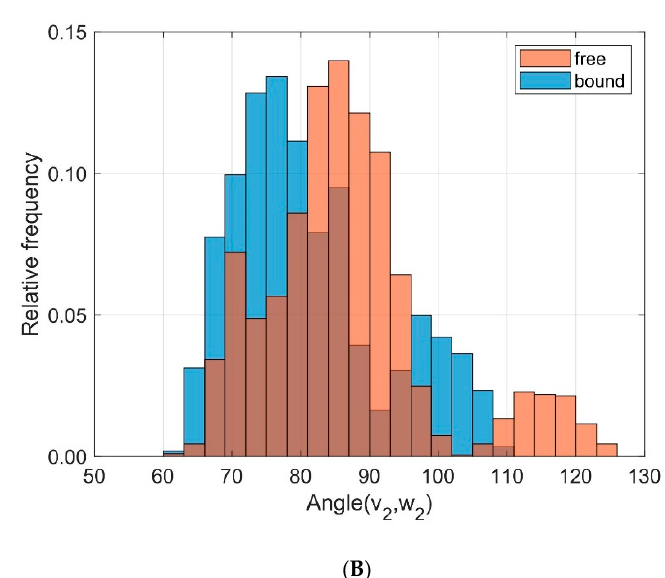
Figure 8. Frequency distribution of angles between corresponding principal component eigenvectors of domains MHC α 1 and MHC α 2 for bound (blue) and unbound states (orange). ( A ): Angles between eigenvectors v 1 , w 1 corresponding to the main extensions ( D = 0.255); ( B ): Angles between v 2 , w 2 ( D = 0.290).